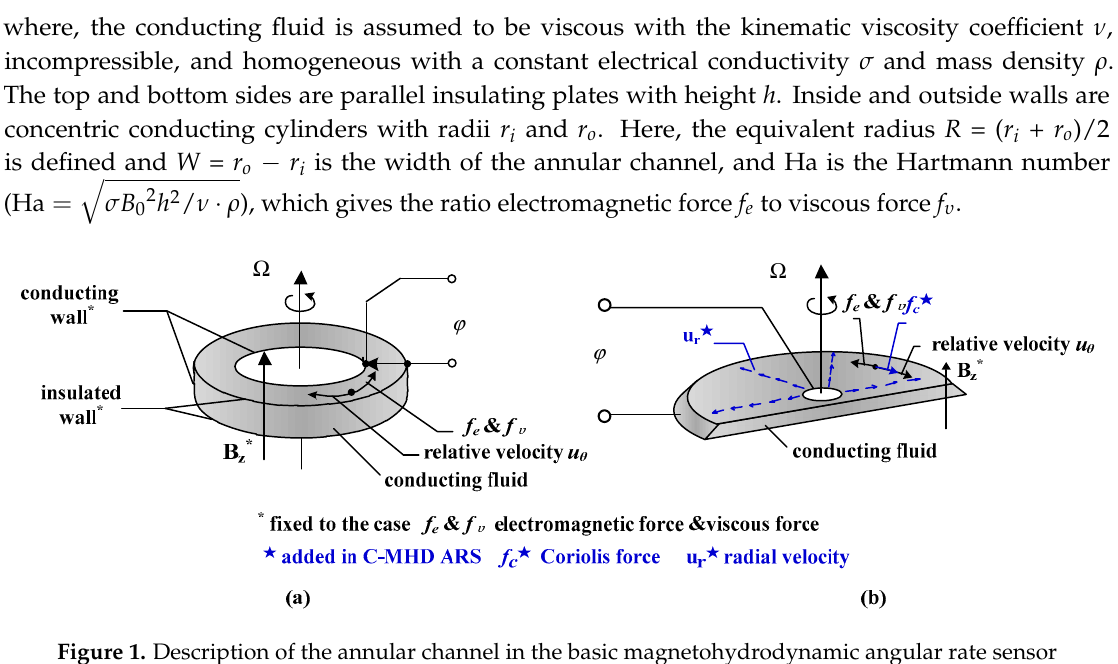
Figure 1. Description of the annular channel in the basic magnetohydrodynamic angular rate sensor MHD ARS and C-MHD ARS. ( a ) The basic one ( b ) the C-MHD ARS (with Coriolis Effect).